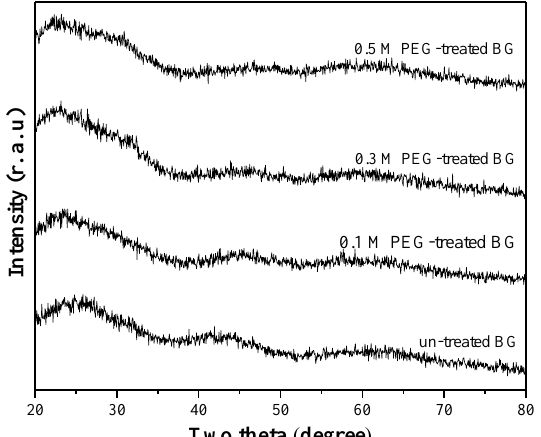
Figure 1. XRD patterns of un-treated BG powder and 0.1 M, 0.3 M, and 0.5 M PEG-treated BG powders.